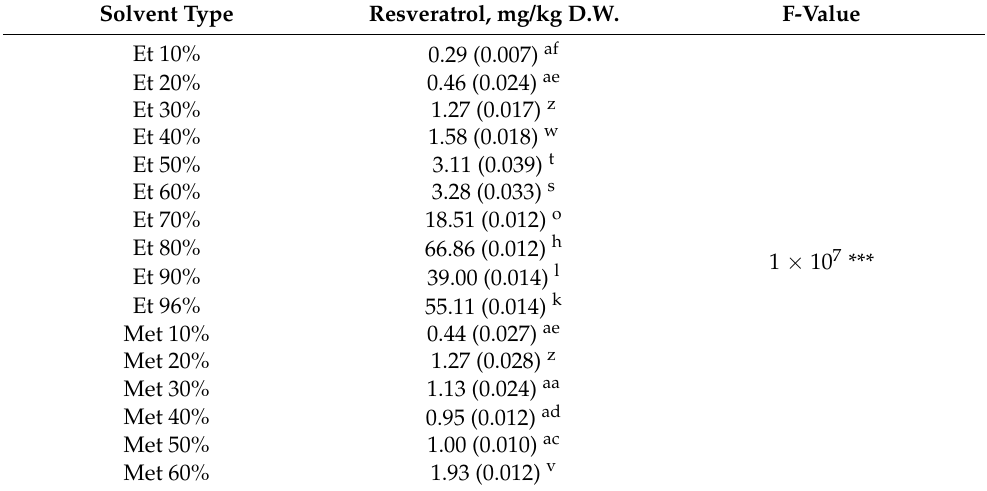
Table 1. Analysis of variance for trans-resveratrol content for the samples extracted with different solvents. Solvent Type Resveratrol, mg/kg D.W.